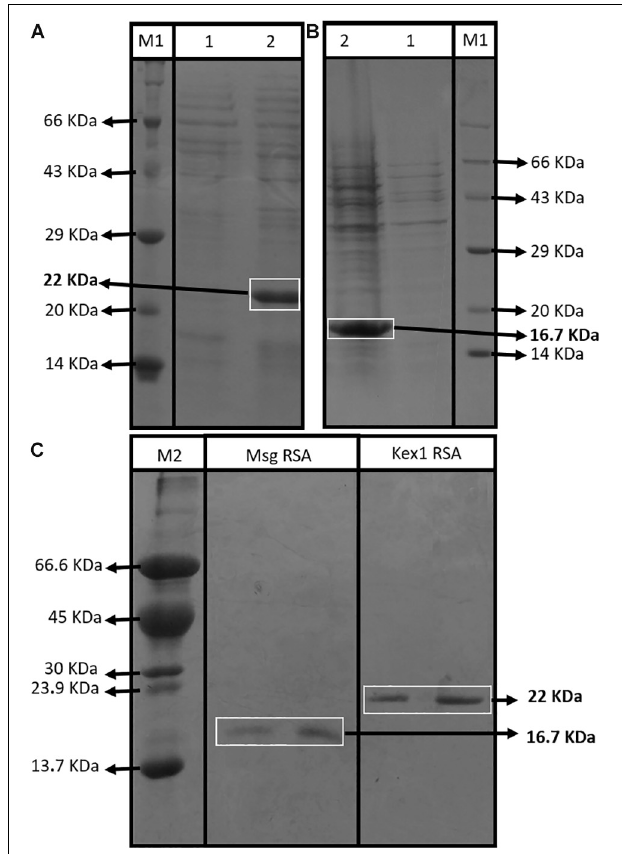
FIGURE 2 | Assessment of the RSA expression and purification process. SDS-PAGE profiles of non-induced (1) and induced (2) E. coli XJb (DE3) cells transformed with the expression vector with the Kex1 RSA (A) and the Msg RSA (B) ; and SDS-PAGE profiles of purification products of the Msg RSA and Kex1 RSA, after IMAC protocol (C) . Two different protein molecular weight standards were used, the Roti § -Mark standard from Carl-Roth § (M1) and one produced “in house” (M2). The bands of interest and their theoretical molecular weight are highlighted (16.7 kDa for Msg RSA and 22 kDa for Kex1